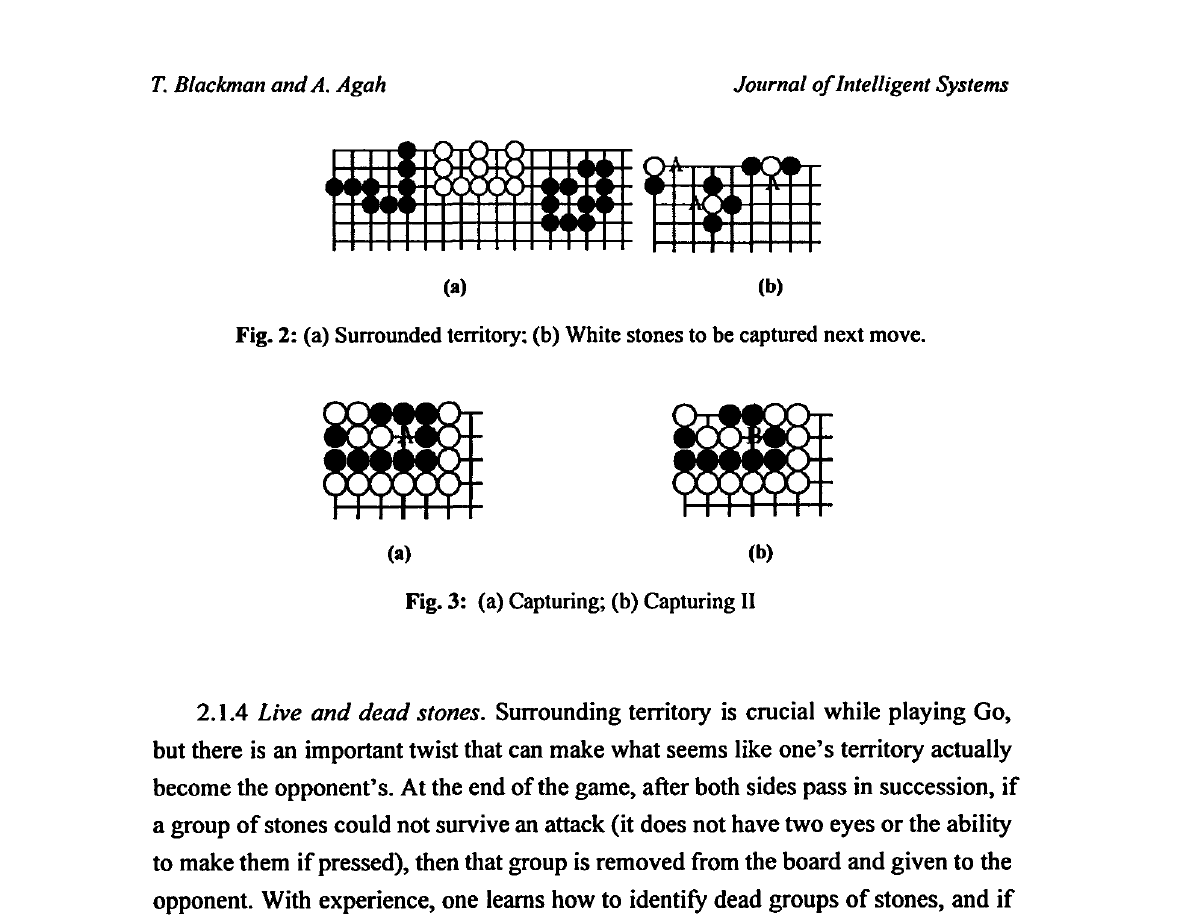
Fig. 3: (a) Capturing; (b) Capturing II